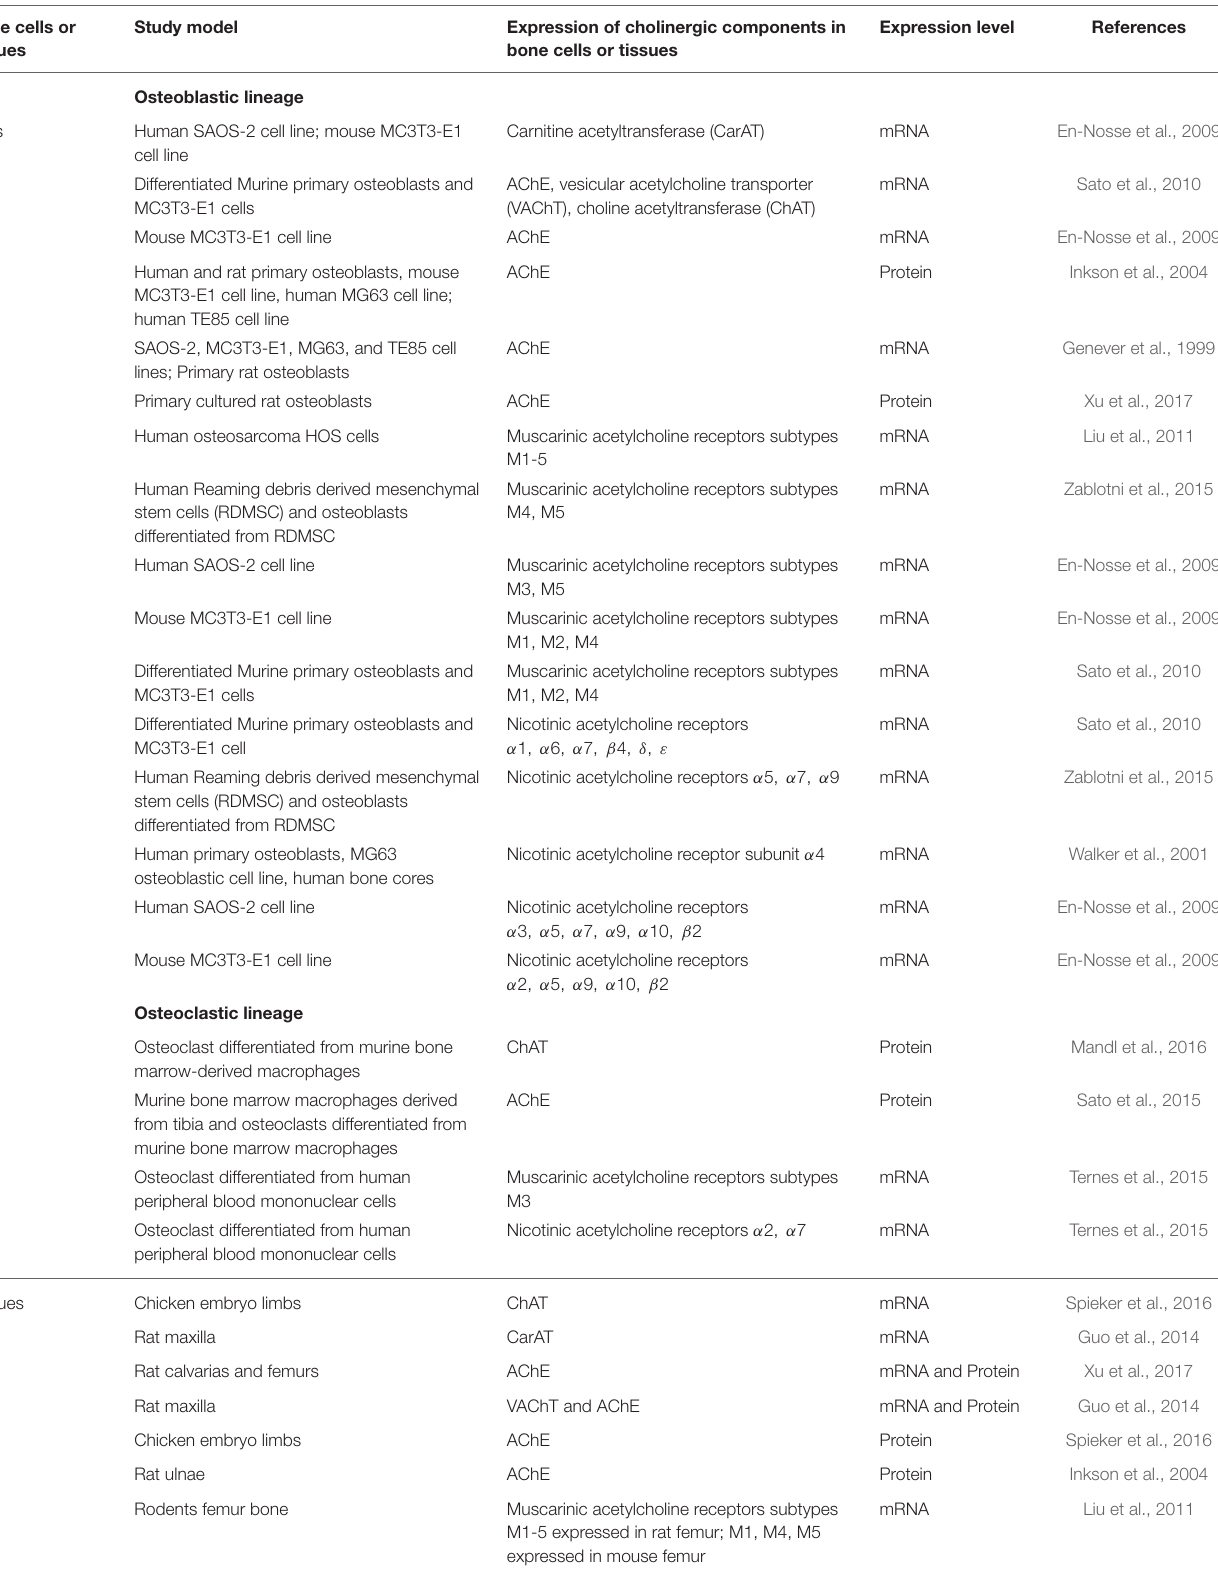
TABLE 1 | Expression of cholinergic components in bone cells or